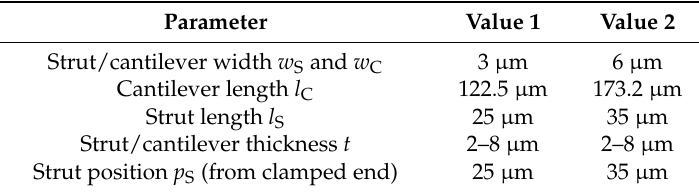
Table 2. Dimensions of the fabricated test